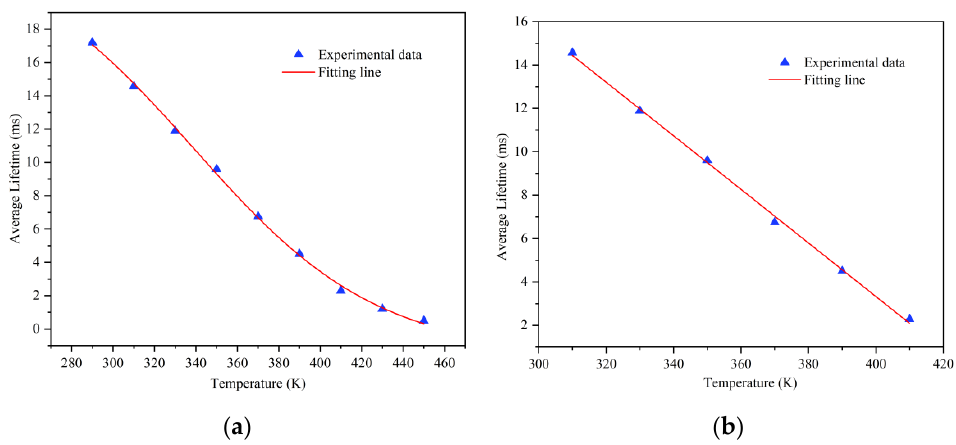
Figure 9. ( a ) The relationship between fluorescence lifetime and temperature in the range of 290 to 450 K. ( b ) The relationship between fluorescence lifetime and temperature in the range of 310 to 410